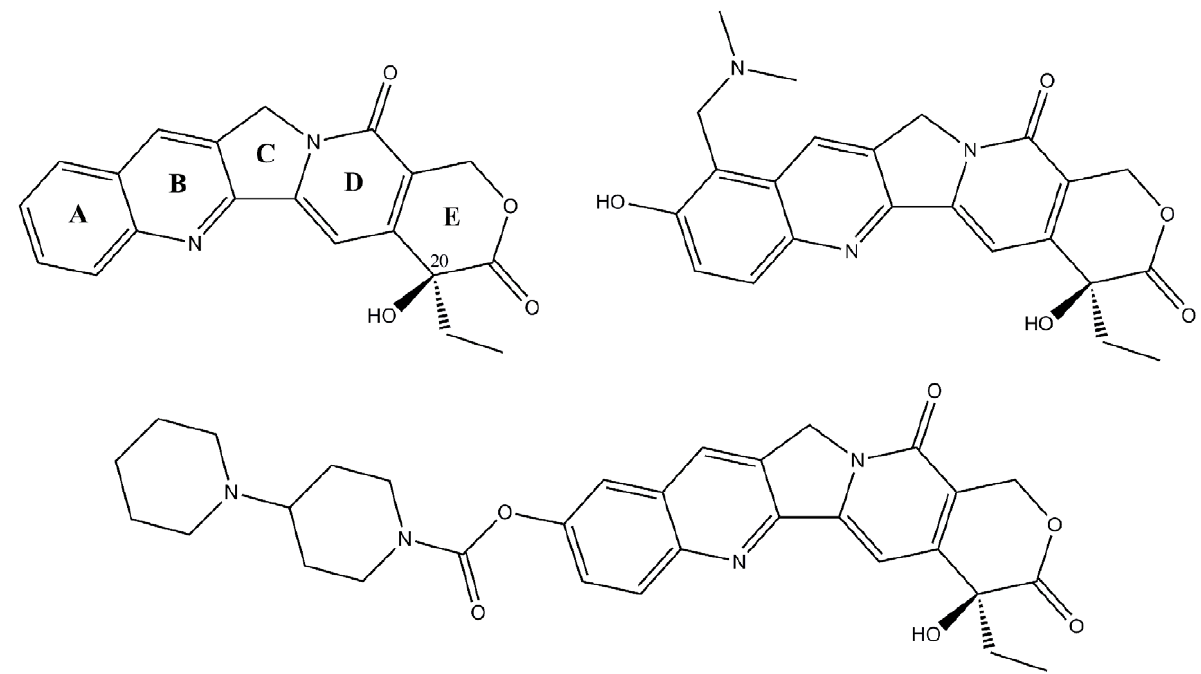
Figure 1. Chemical structures of camptothecins. Shown are the structures of camptothecin (CPT; top left), topotecan (TTC; top right), and irinotecan (CPT-11; bottom).